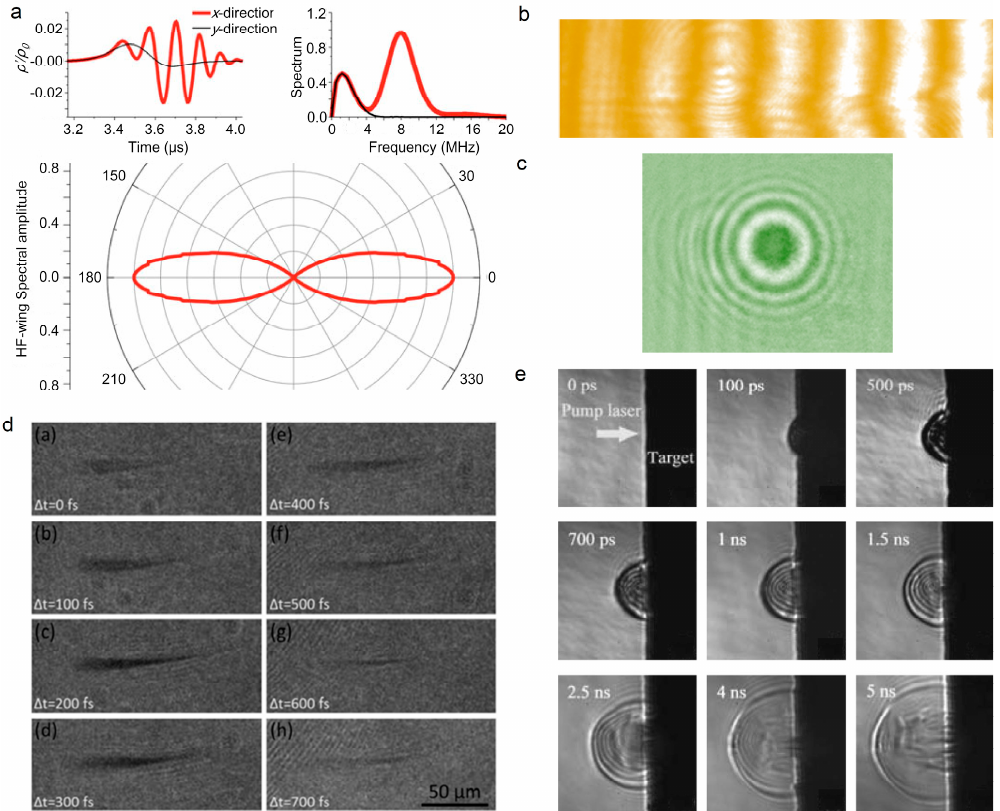
Figure 6. Sensing of plasma density in filament. ( a ) Acoustic signals that are induced by plasma grating [127]. ( b ) Interferometric images for femtosecond laser that are induced plasma in fused silica [128]. ( c ) Longitudinal diffraction fringe [119]. ( d , e ) Time-resolved shadowgraphs: ( d ) transient plasma that is induced by spatiotemporally focused femtosecond laser inside fused silica [129]; ( e ) material ejection during the ablation of an aluminum target [130].